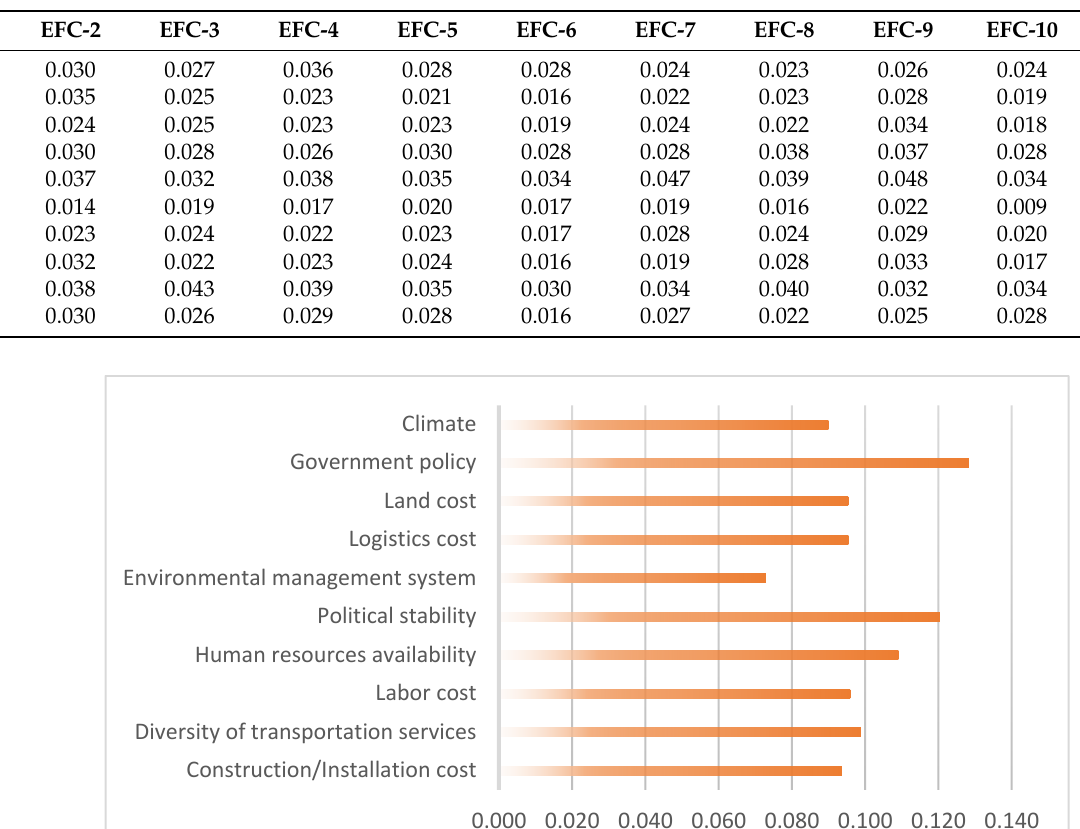
Table 5. The defuzzied total influence matrix construction.